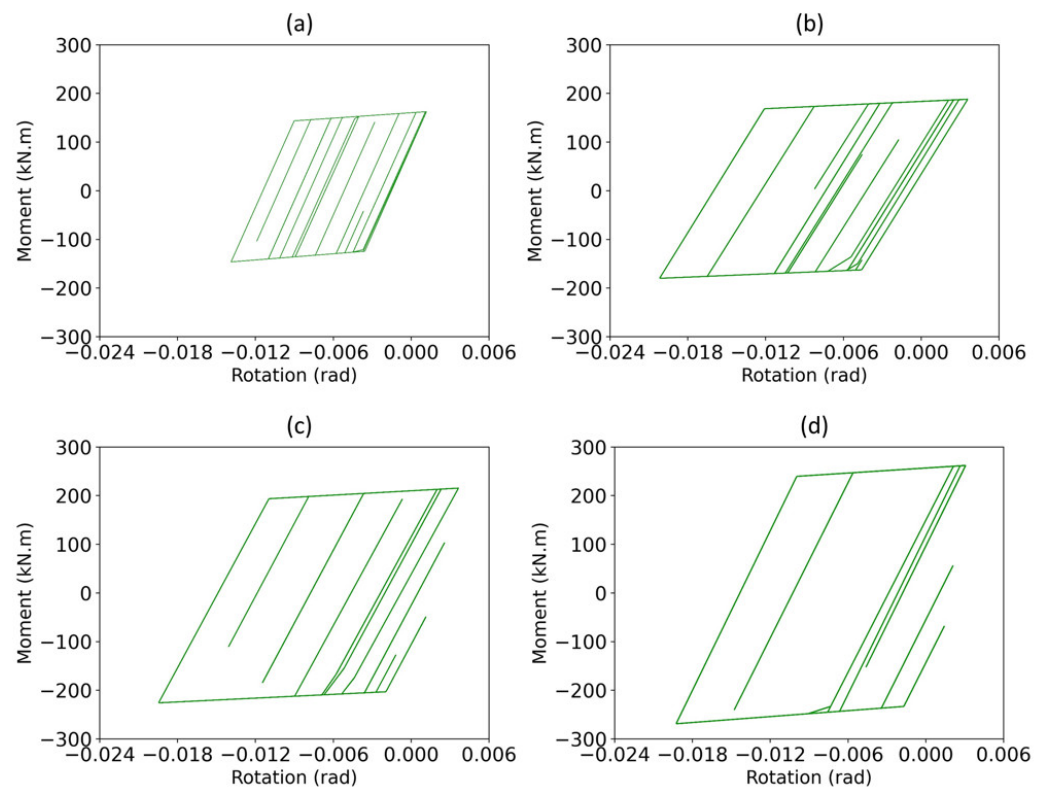
Figure 29. Moment–rotation hysteresis behavior of point A on the 14th floor of 15-story frames with 200 mm SPSW holes exposed to the Northridge earthquake: ( a ) 30% rigidity; ( b ) 60% rigidity; ( c ) 80% rigidity; and ( d ) 100% rigidity.